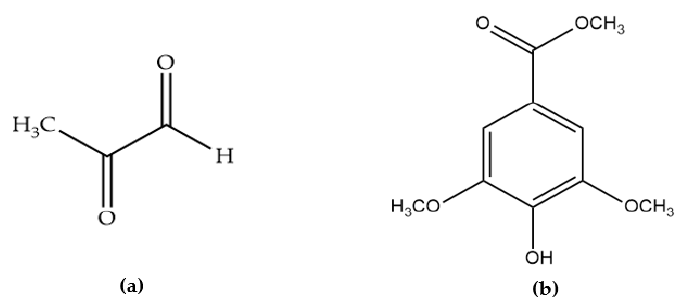
Figure 3. Structure of ( a ) methylglyoxal (MGO) and ( b ) methyl syringate (MSYR).